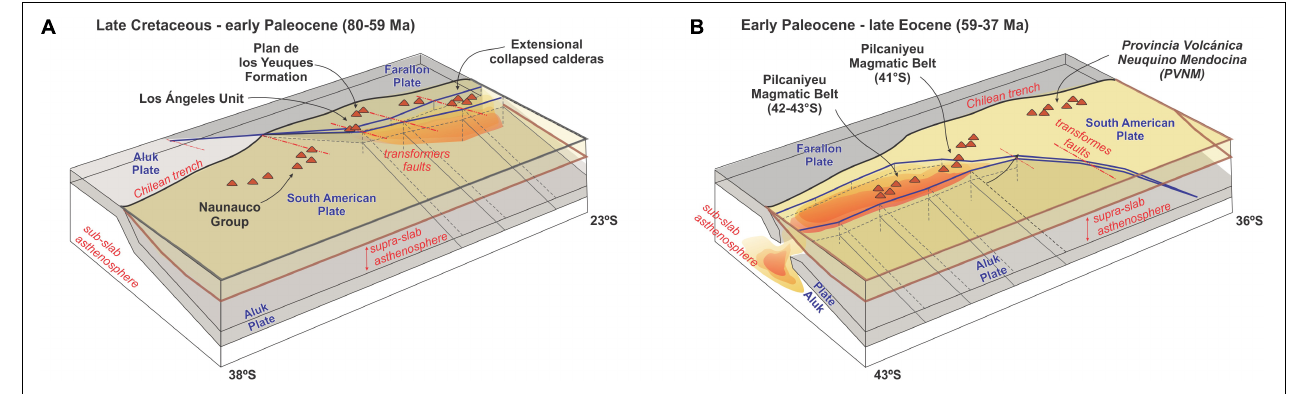
FIGURE 14 | Schematic model representing the passage of the Farallon–Aluk spreading ridge since (A) Late Cretaceous–early Paleocene time (80–59 Ma) to (B) Early Paleocene–late Eocene (59–37 Ma), and the main magmatic units from each